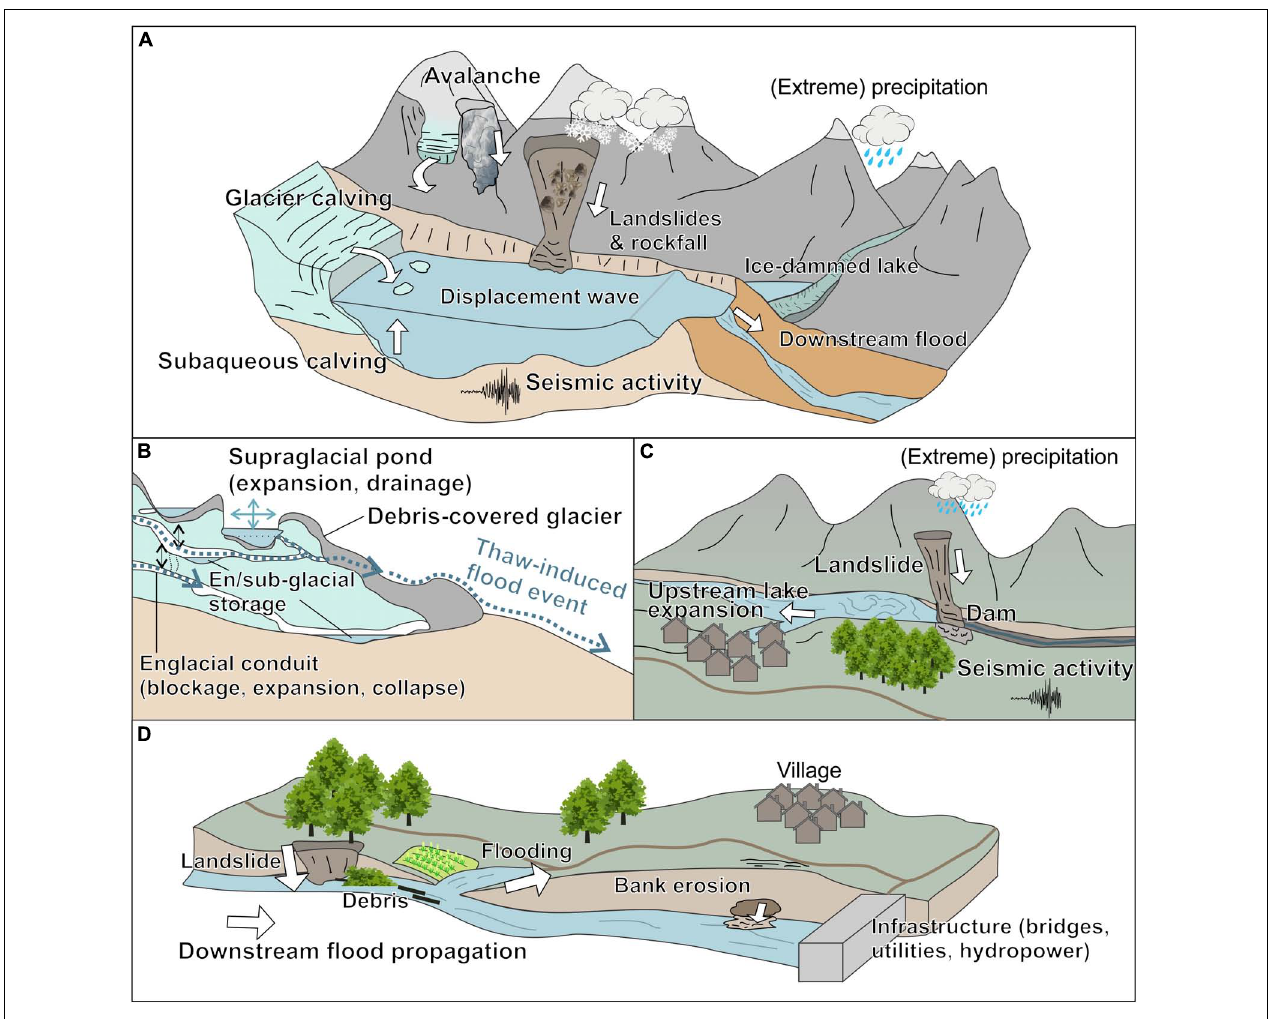
FIGURE 2 | Conceptual diagram highlighting cascading hazard process. (A) Illustrates an outburst flood triggered at proglacial lakes, which can be further exacerbated by additional elements such as landslides, avalanches and rockfalls and avalanches triggered by precipitation or seismic activity. (B) Shows a supra- or englacial-flood event emanating from debris-covered glaciers. (C) Illustrates how a landslide triggered by seismic activity or precipitation can dam a river and cause upstream lake expansion. (D) Shows how a landslide-dammed river could fail catastrophically, causing downstream propagation of flood waters and debris that could cause potential societal impacts to populations and